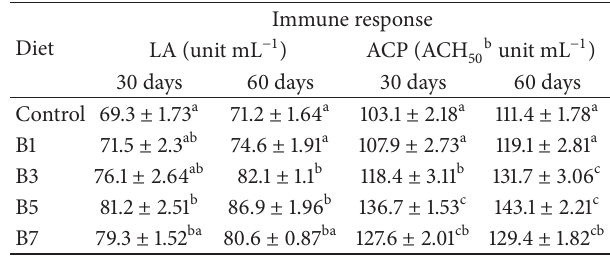
Table 6: Superoxide dismutase (SOD) and malondialdehyde (MDA) activities observed on different sampling days after feeding Labeo rohita with banana peel flour (BPF) supplemented